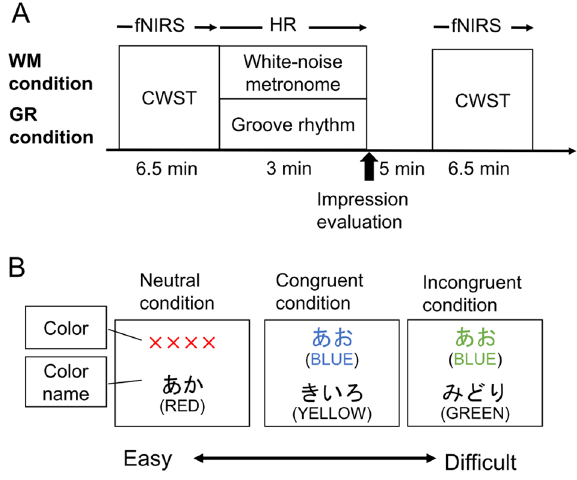
Figure 5. ( A ) Experimental protocol. ( B ) Color-word Stroop task (CWST). There are three conditions: neutral, congruent, and incongruent. In incongruent trials, interference occurs and creates a delayed reaction time compared to neutral trials because in the top row, the word meaning does not match the ink color. We calculated the differences in reaction time for incongruent minus neutral conditions to determine Stroop interference time (Stroop RT interference ), which represents executive